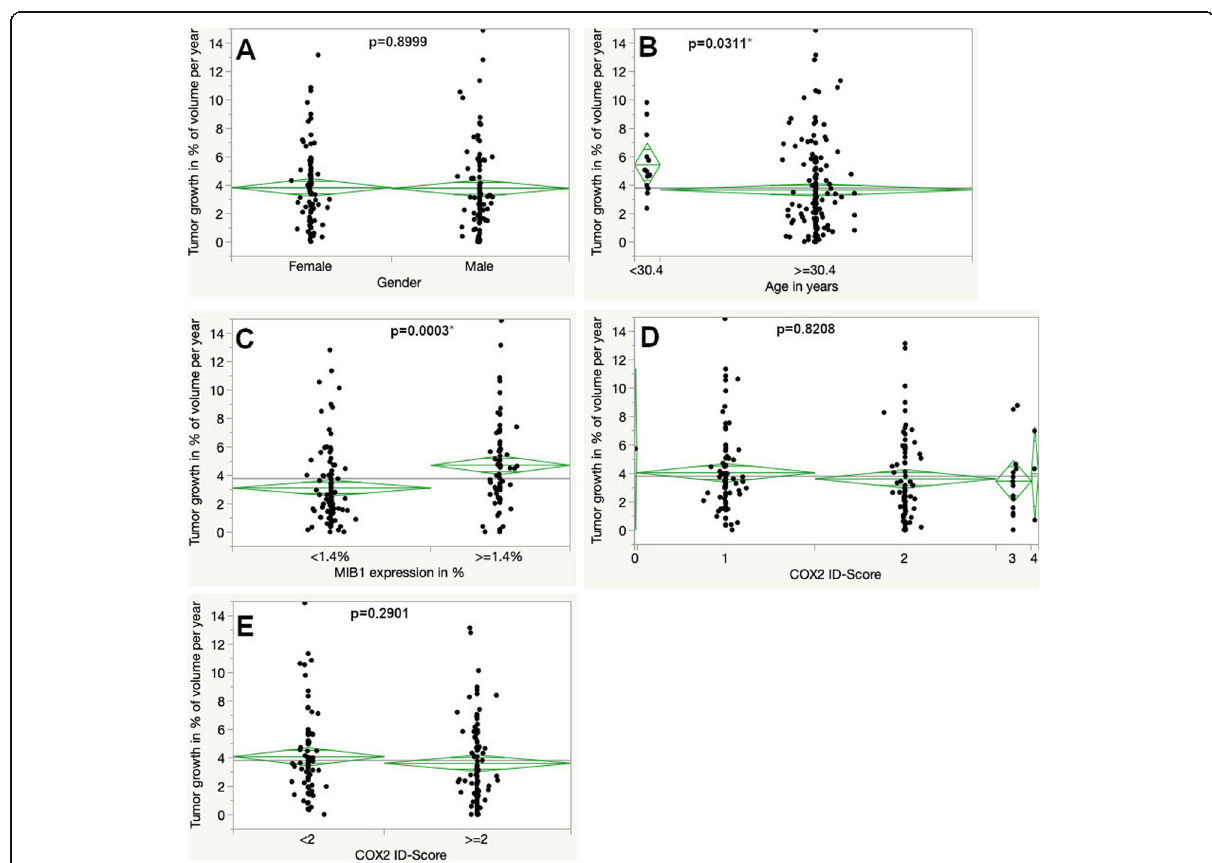
Fig. 3 Distribution of preoperative tumor volume ( a ), percentual tumor growth ( b ), MIB1 expression ( c ) and COX2 ID-score ( d ). ANOVA, asterisk (*) represents statistically significant